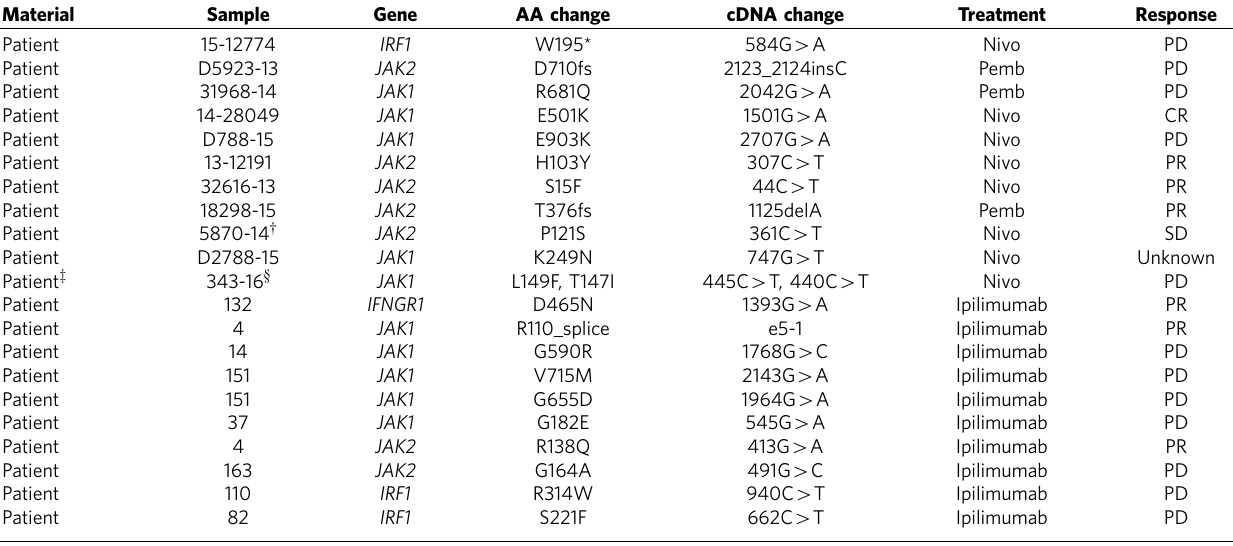
Table 2 | Mutations in biopsies from patients receiving anti-PD1 ( n ¼ 59) and anti-CTLA4 ( n ¼ 110) immunotherapy.